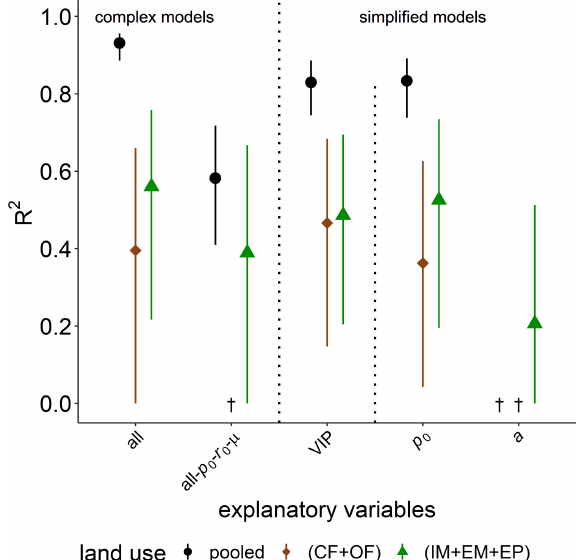
Figure 7. Explained variability ( R 2 ) of time of capacity excess, t exc , during substrate-induced respiration ( t ave ) by different combi- nations of explanatory variables for all land uses (pooled) or only cropland (CF + OF) and grassland (IM + EM + EP), respectively. The all- p o - r o - µ model includes all explanatory variables except for microbial variables. The VIP model include the variables of impor- tance in predicting t exc (please see the text for more information). † No variability